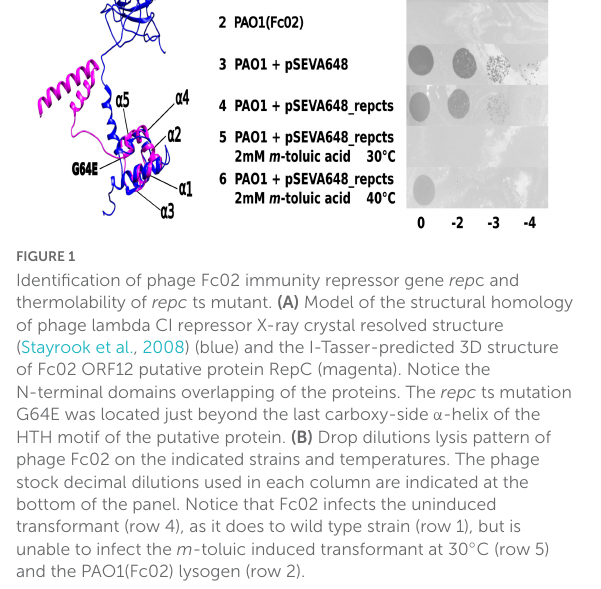
0.3 and then 2 ml of pre-heated medium was added to rapidly reach 40 ◦ C up-shifted temperature. Samples of 1 ml were collected 5, 10, 20,